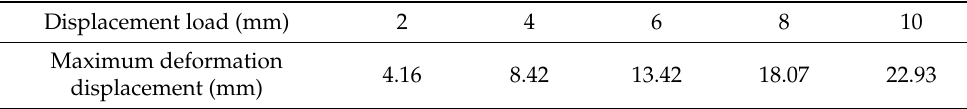
Figure 4. Finite element analysis of the micro-power piezoelectric generator. ( a ) Meshing model; ( b ) deformation dia- gram. Table 2. Deformation displacement of the flexure strip.